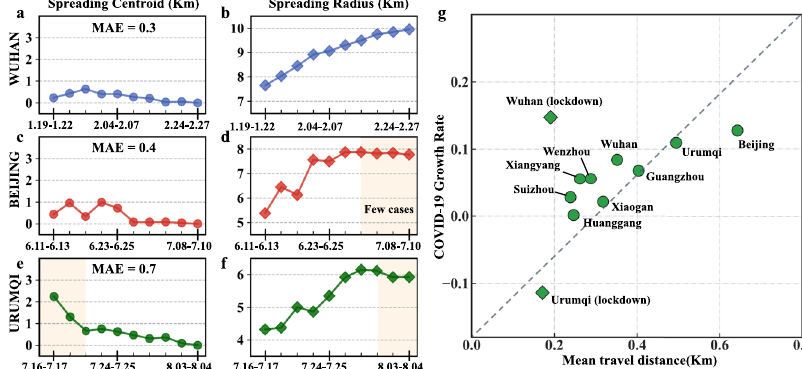
Fig. 1 The temporal spreading pattern of COVID-19. a – f The cumulative spreading centroid and spreading radius in Wuhan, Beijing, and Urumqi, respectively. g Relation between the mean travel distance of people in each city and the corresponding COVID-19 growth